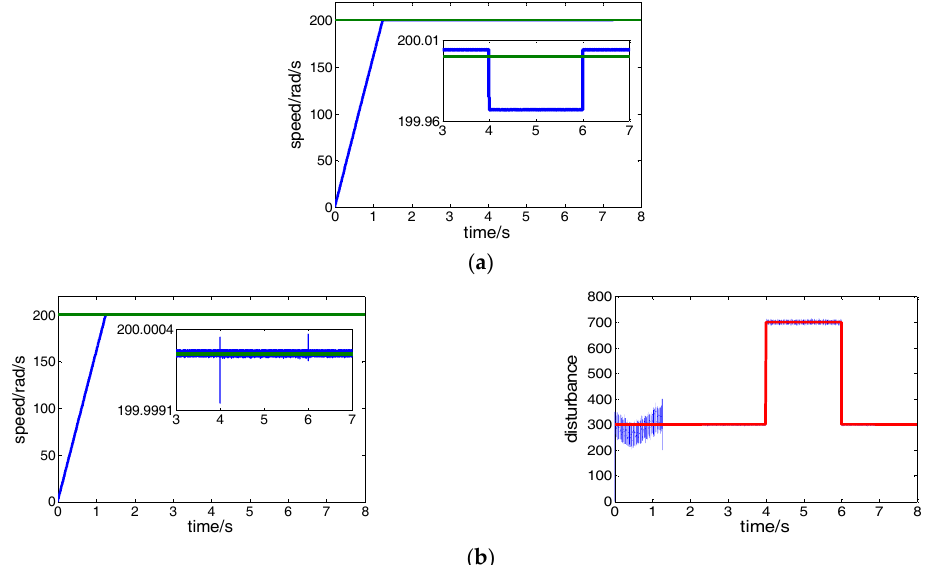
Figure 7. Simulation comparisons of the two controllers against step change of the load torque: ( a ) Conventional PI and ( b ) proposed CRFTPC.